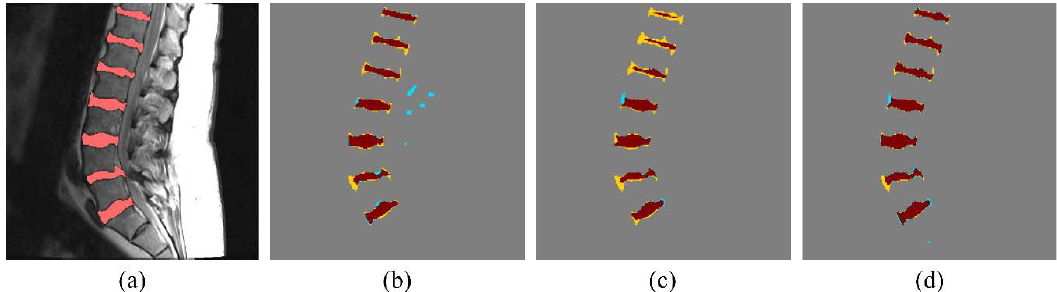
Figure 9. Segmentation results from all networks illustrating the outlier case of cascaded U-net. Brown area, yellow area, and blue area denote correctly segmented area, under-segmented area, and over segmented area, respectively. ( a ) Input image with label. ( b ) U-net result. ( c ) Cascaded U-net result. ( d ) BSU-net result.